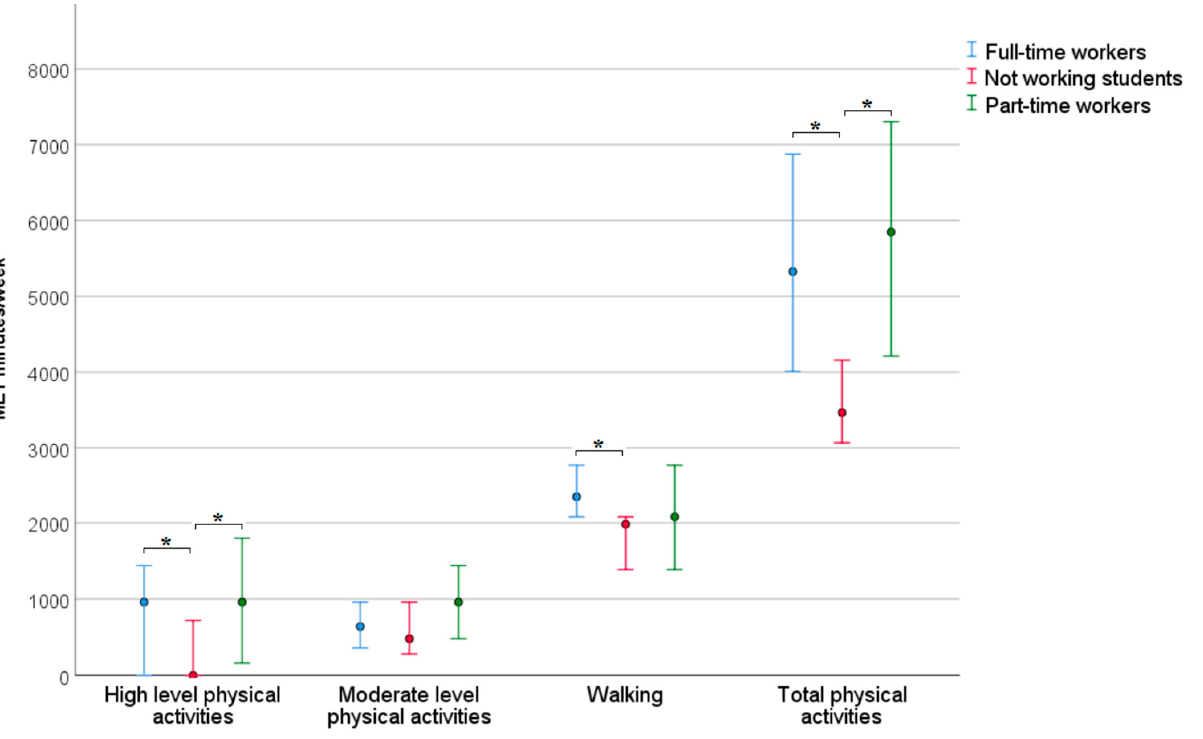
Figure 1. Median and Q1–Q3 of the physical activity of students in different groups according to engagement in work. * p < 0.05 indicates a significant difference.